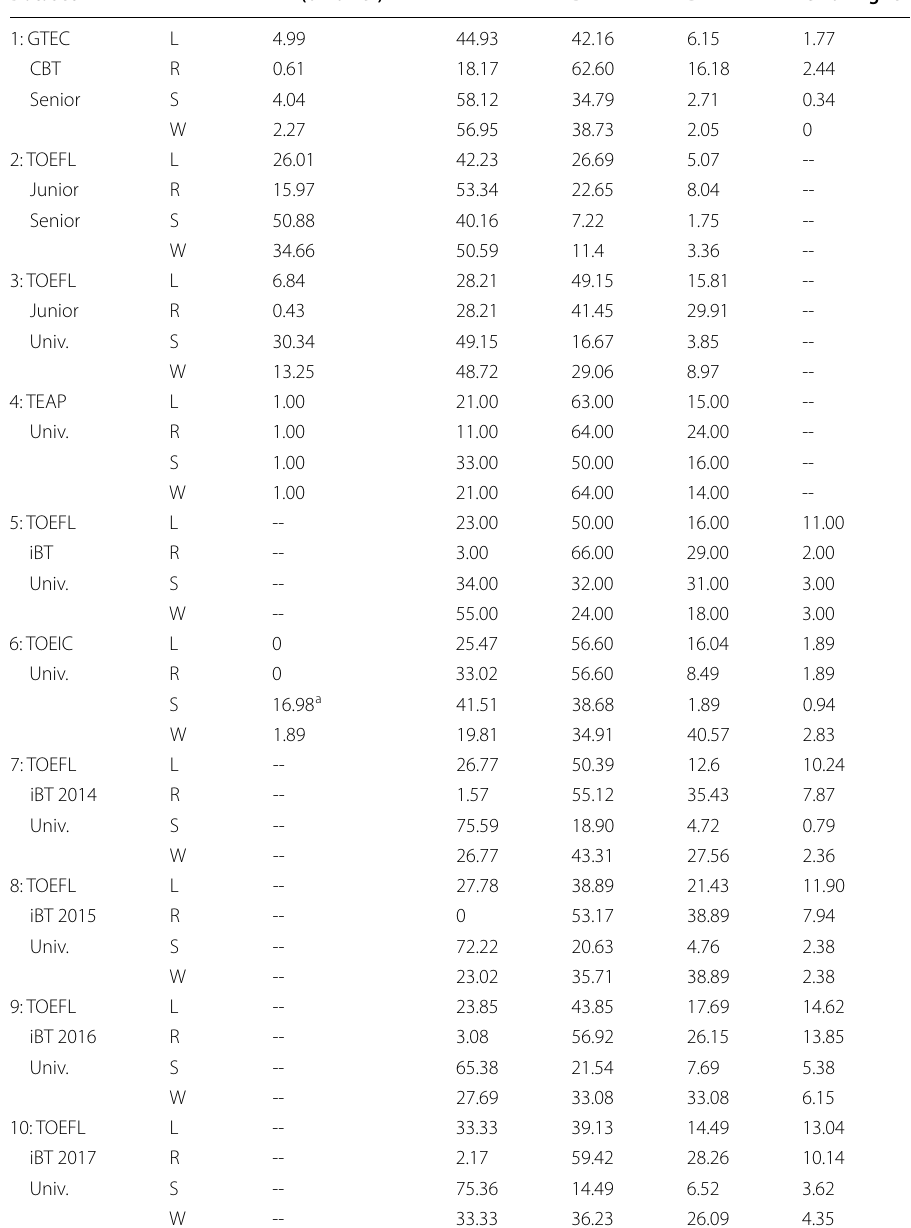
Table 4 Percentages of participants’ CEFR levels for each dataset in Study 1